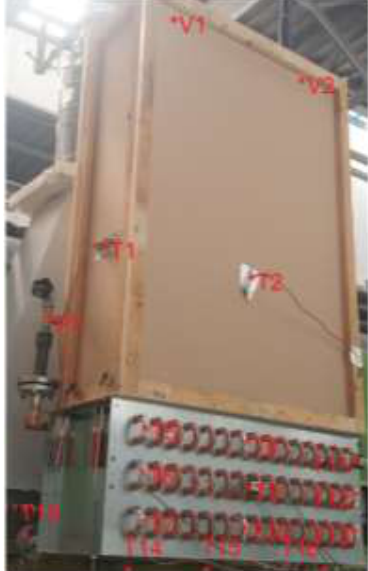
Fig. 7. Experimental equipment in laboratory – part with condensator: P1 – measurement of the pressure in the heat